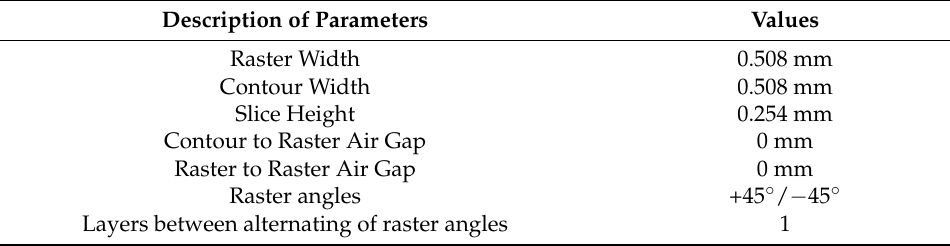
Table 5. Printing